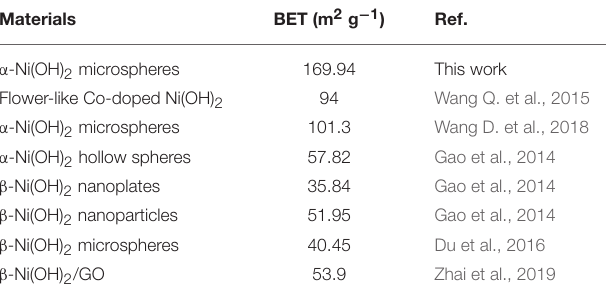
TABLE 1 | Previously reported BET specific surface areas of Ni(OH) 2